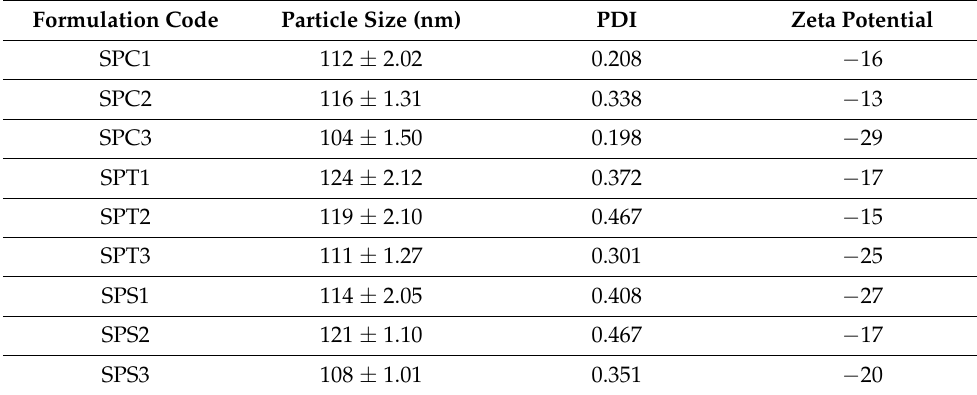
Table 2. Particle size and zeta potential of developed